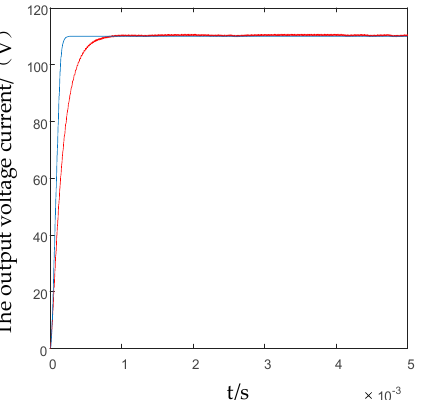
12 of 16 Figure 8. Resonant circuit output simulation plot: ( a ) simulation of the voltage output from the resonant circuit; ( b ) simulation of the current output from the resonant circuit. 5.3. Output Voltage Stability Comparison for Stable Loads In the following, first, the difference between the two algorithms in stabilizing voltage and current when the load is constant is analyzed. The non-contact excitation motor can adapt to various working conditions and meet the actual requirements. According to Figure 9, we can compare the simulation graphs of the output voltage under the two algorithms. The red line represents the result of the system output voltage under the traditional sliding mode control: the output voltage is stable at 110 V, and the stabilization time is 0.001 s. The blue line shows the result of the output voltage under the improved sliding mode control; it can be seen that in the simulated waveform of the improved sliding mode control, the output voltage is finally stabilized at 110 V. Compared